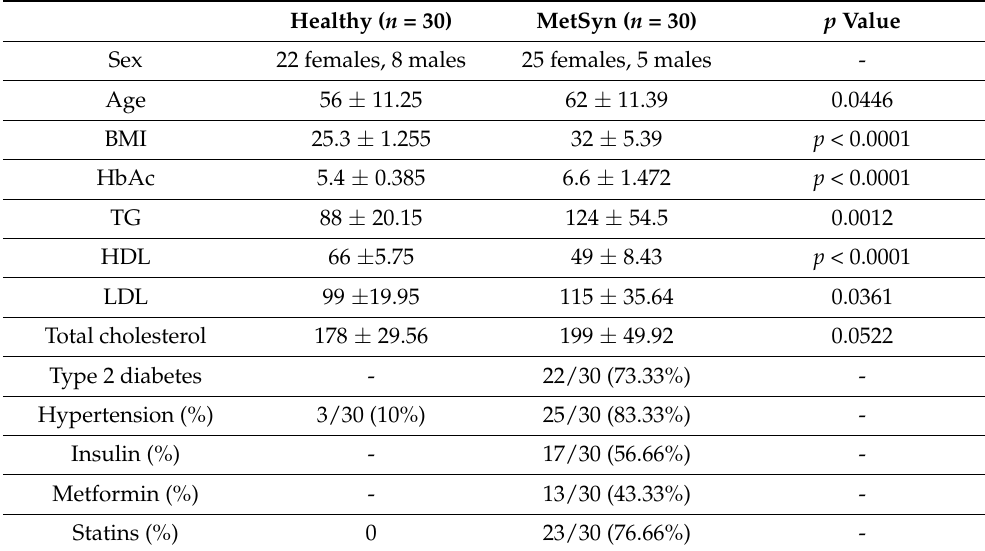
Table 1. Patients’ characteristics; BMI—body mass index, HbAc—Glycated hemoglobin, TG— Triglycerides, HDL—high-density lipoprotein, LDL—low-density lipoprotein. %—percentage of patients under